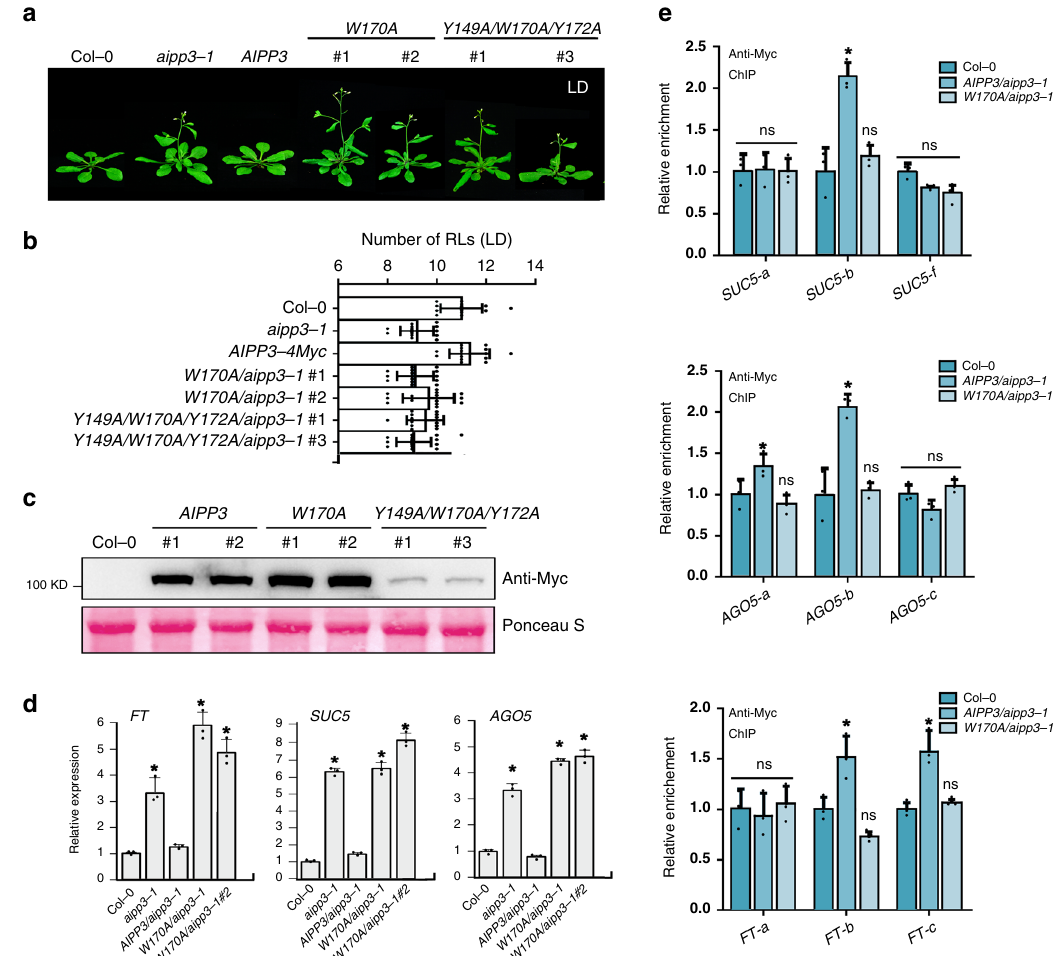
Fig. 6 The H3K27me3-binding activity is essential for AIPP3-mediated repression of fl owering and gene expression. a The fl owering phenotypes of the aipp3-1 mutant for its complementary lines when transformed with the wild-type AIPP3 genomic DNA, mutated AIPP3 in which the key amino acids for H3K27me3-binding were mutated. For the mutated transgene, two randomly selected transgenes were used for the analysis. The plants were grown under LD. b The column showing the numbers of rosette leaves (LDs) of different AIPP3 transgene plants upon fl owering under the LD condition. Black horizontal lines represent the mean, and the error bars represent ±S.D. from the number of plants counted for each genotype. n = 15 per line. c Western blotting result showing the accumulation levels of AIPP3 proteins in different transgenes. Ponceaus staining serves as protein loading controls. d The relative mRNA levels of the selected target genes of the BAH – PHD – CPL2 complex in the wild-type, aipp3-1 , and different AIPP3 transgene plants. Their levels are presented relative to Col-0. The data are the means ± S.D. of three biological repeats. Unpaired one-tailed t test was performed and * p value < 0.01. e ChIP-qPCR resulting showing AIPP3 occupancy at the selected target genes in AIPP3 and W170A transgenes. The data are the means ± S.D. of three biological repeats. Unpaired one-tailed t test was performed and * p value < 0.01. ns no signi fi